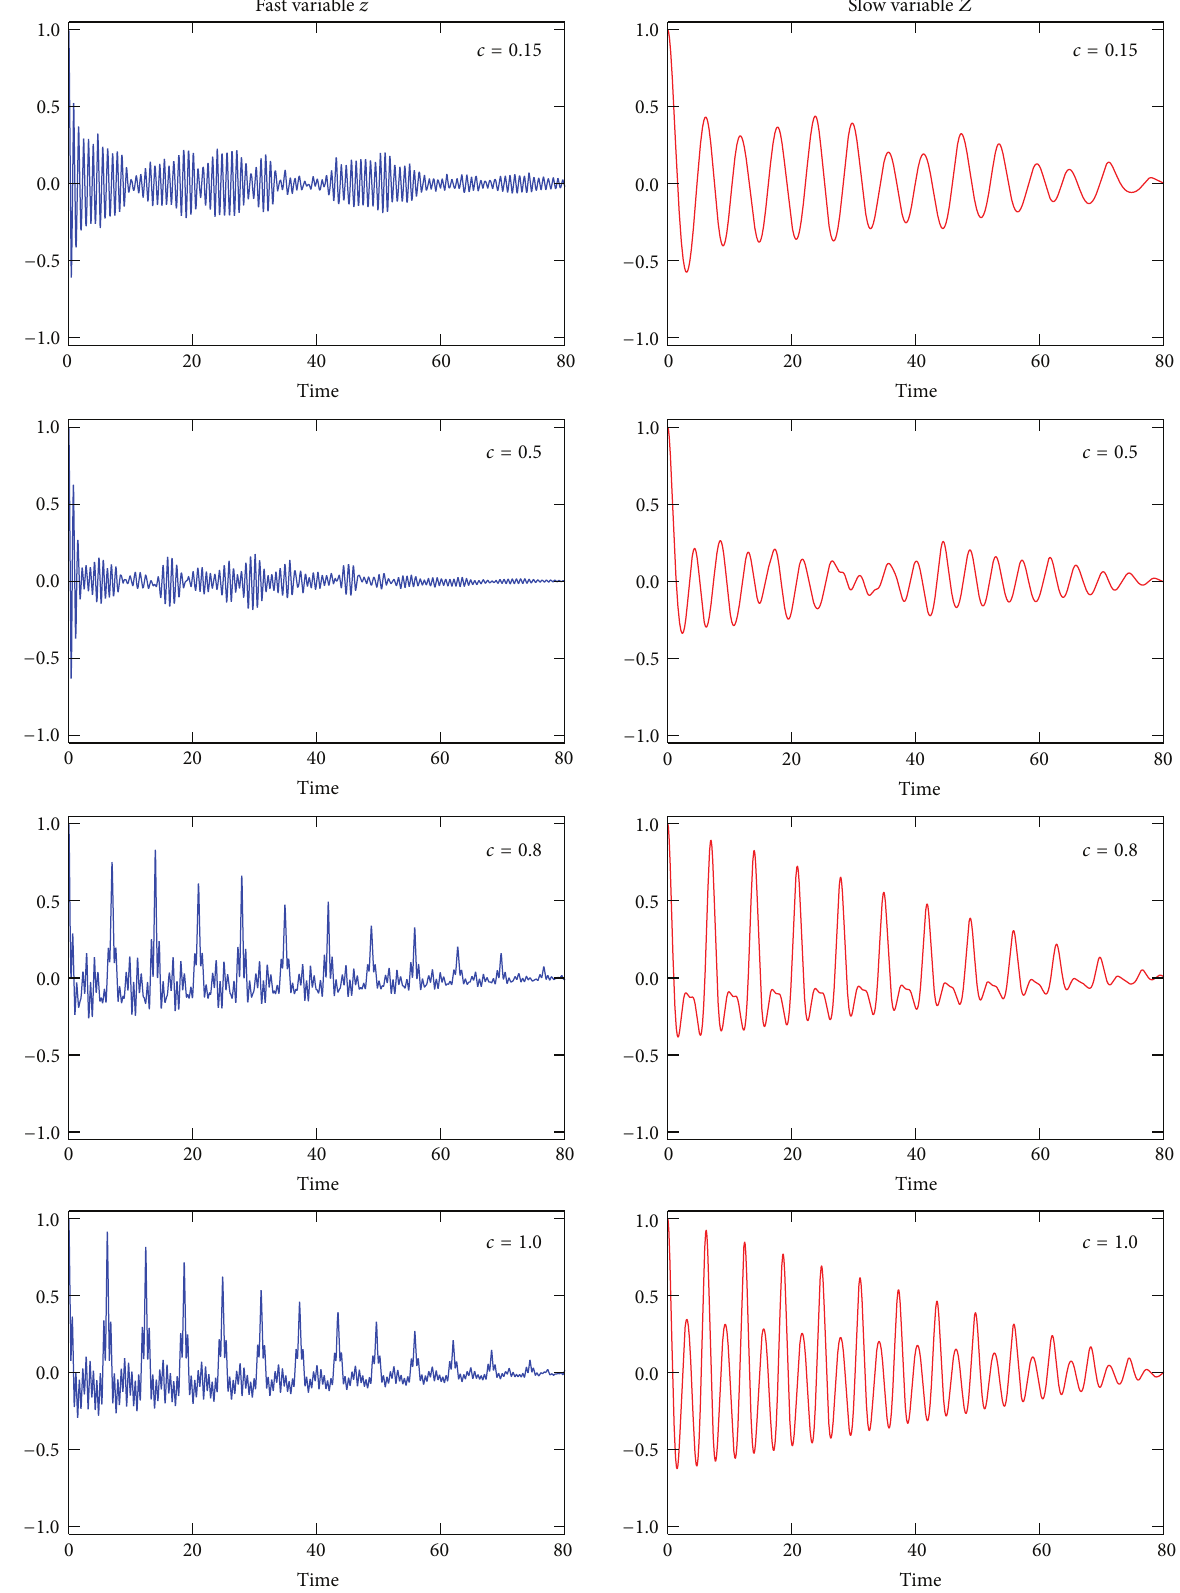
Figure 3: Autocorrelation functions for dynamic variables 𝑧 and 𝑍 for different parameter 𝑐